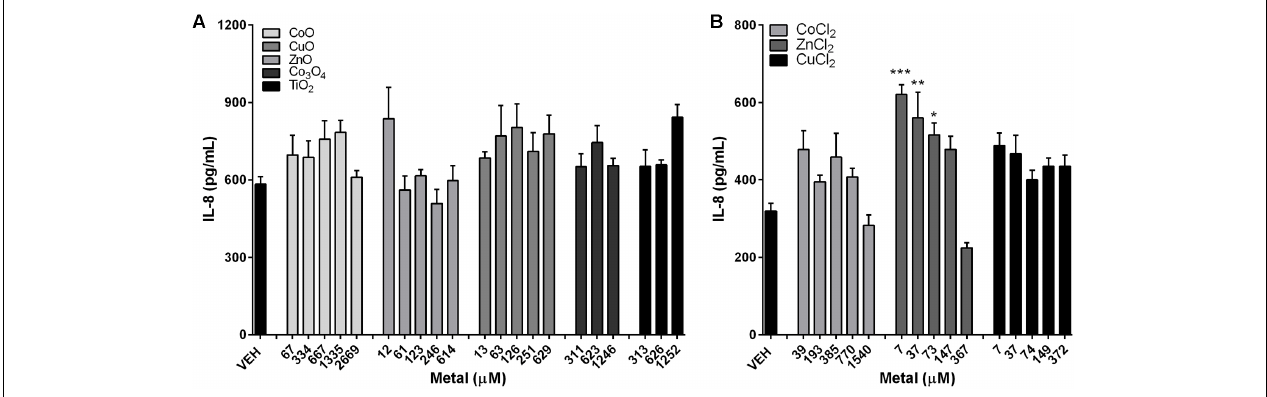
FIGURE 5 | Concentrations of IL-8 expression in the A549 cells after treatment with metal-oxide NPs or metal chlorides. IL-8 levels in A549 cells after treatment with (A) metal-oxide NPs, and (B) metal chlorides. NPs were treated at various doses ranging 1–200 µ g/mL. Note that the mass doses were converted into molar concentrations. Values are mean ± SEM from eight independent experiments. ∗ p < 0.05, ∗∗ p < 0.01, and ∗∗∗ p < 0.001 vs. VEH.